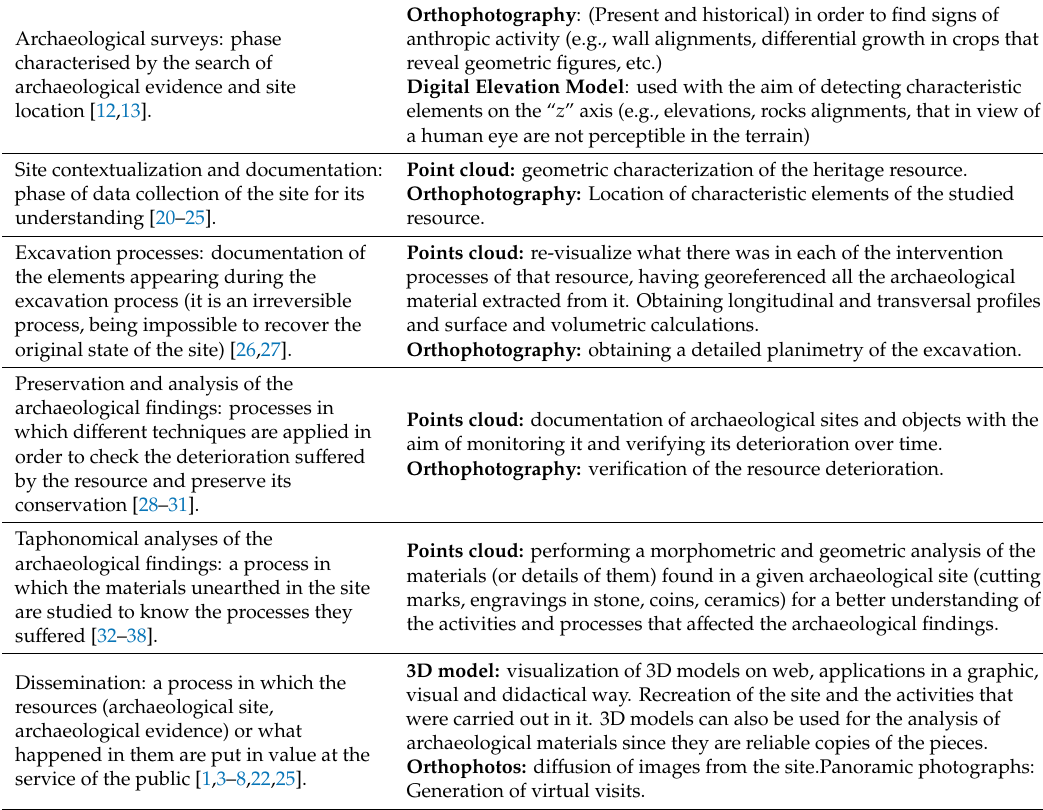
Table 2. Main geomatic procedures used in di ff erent archaeological